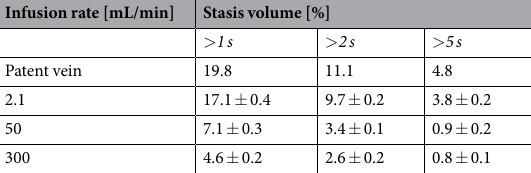
Table 1. Effect of infusion rate on venous stasis volume for each of the three time thresholds